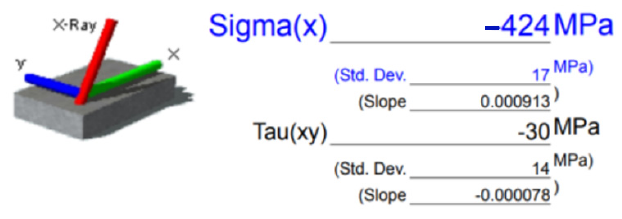
Figure 9. Residual stress prediction by FEA with a laser power of 500 W.